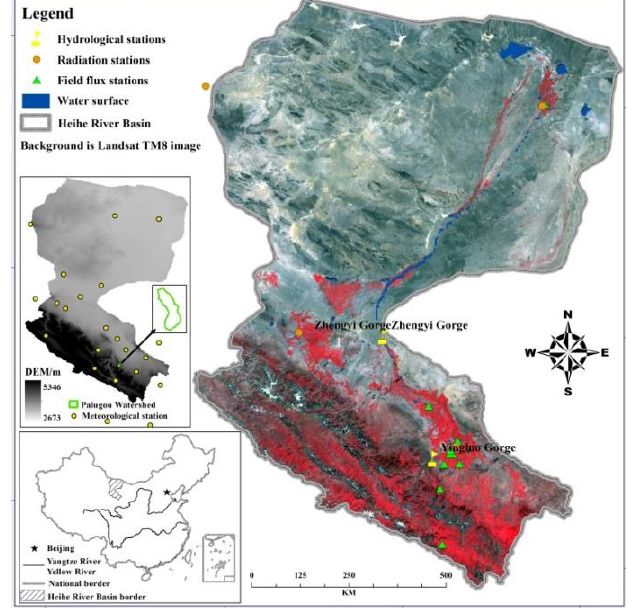
Figure 1. Location of the Heihe River Basin in northwest China with Landsat TM 8 as background. Table 1. List of fields station in the Heihe River Basin used in this study.